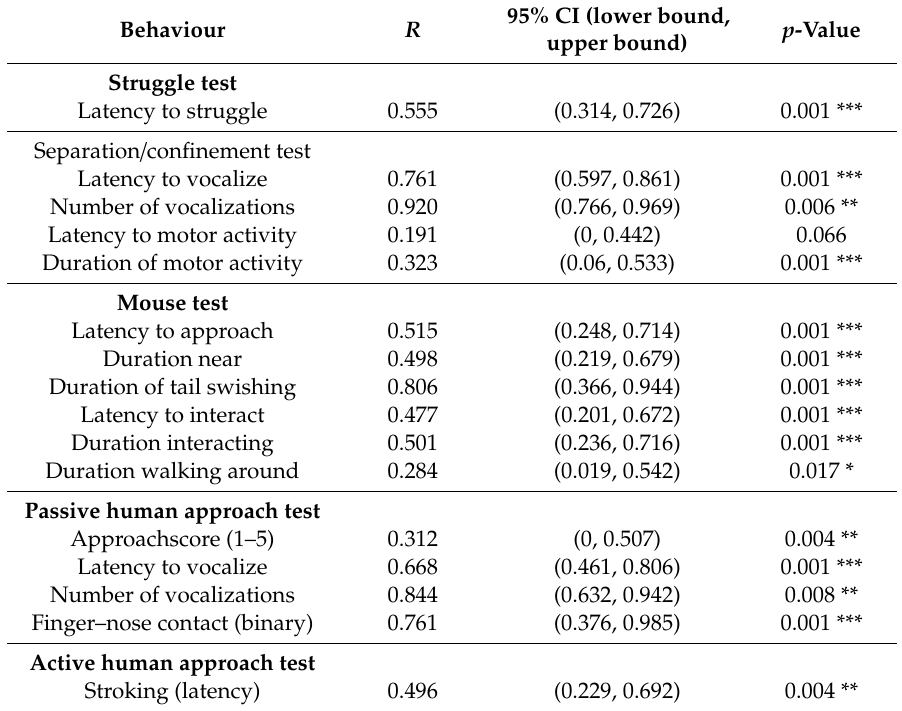
Table 2. Repeatability of the variables analysed for each of the behavioural tests. Intra-class correlation coe ffi cients ( R ), 95% confidence intervals (lower bound, upper bound) based on 1000 bootstrap steps and significance values ( p ) are given. Asterisks indicate significance levels at p < 0.05 *, p < 0.01 **, p < 0.001